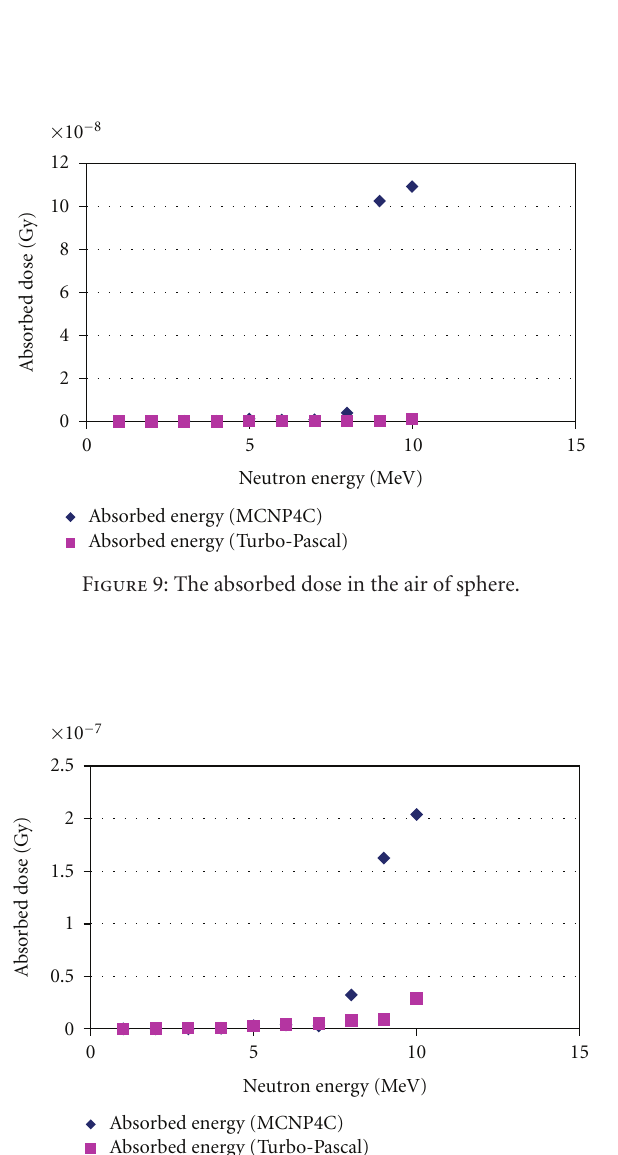
Figure 8: The absorbed dose in the cadmium layer.